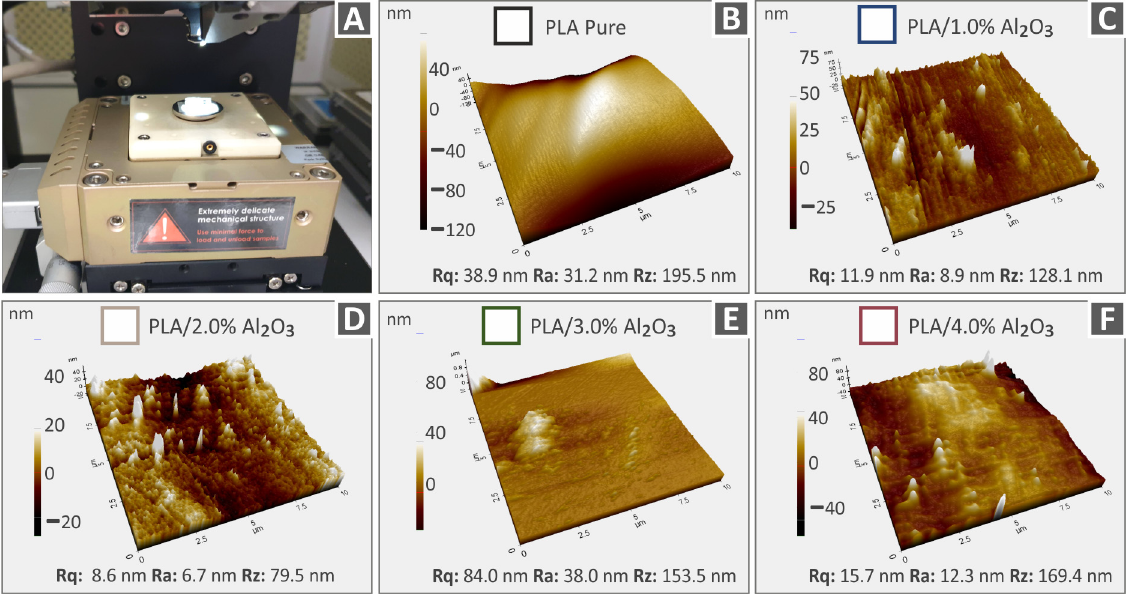
Figure 8. AFM topography images together with the corresponding roughness values (Rq, Ra, Rz) of PLA and PLA/Al 2 O 3 nanocomposite filaments ( A ) AFM setup, ( B ) PLA pure, ( C ) PLA/Al 2 O 3 1.0 wt.%, ( D ) PLA/Al 2 O 3 2.0 wt.%, ( E ) PLA/Al 2 O 3 3.0 wt.%, ( F ) PLA/Al 2 O 3 4.0 wt.%.